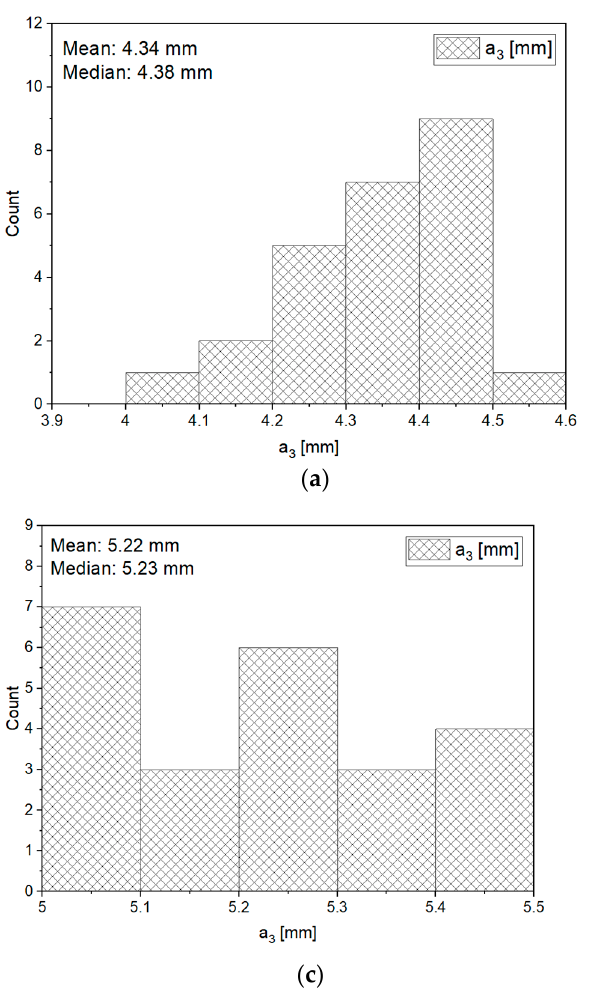
Table 7. Results of analysis of the correlation between grain thickness and medians of cumulated probability distributions of the analyzed mechanical properties of maize grains, * means significant correlations for which p < 0.05.